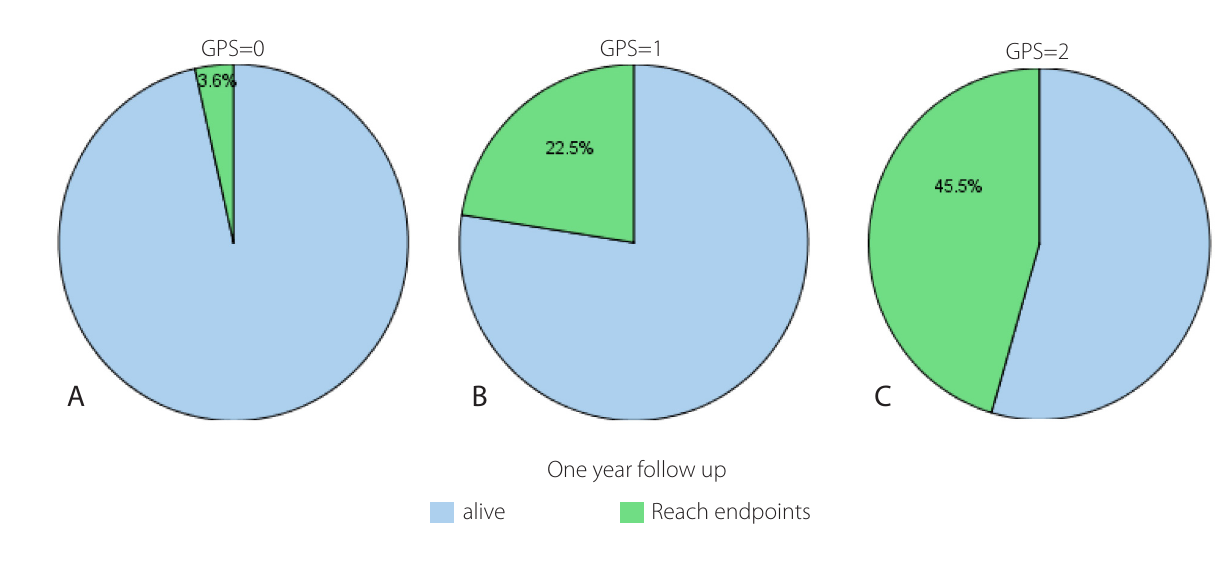
Fig. 1 - Percent of cases which reached endpoints according to the Glasgow prognostic score (GPS). A) GPS 0; B) GPS 1; C) GPS 2.